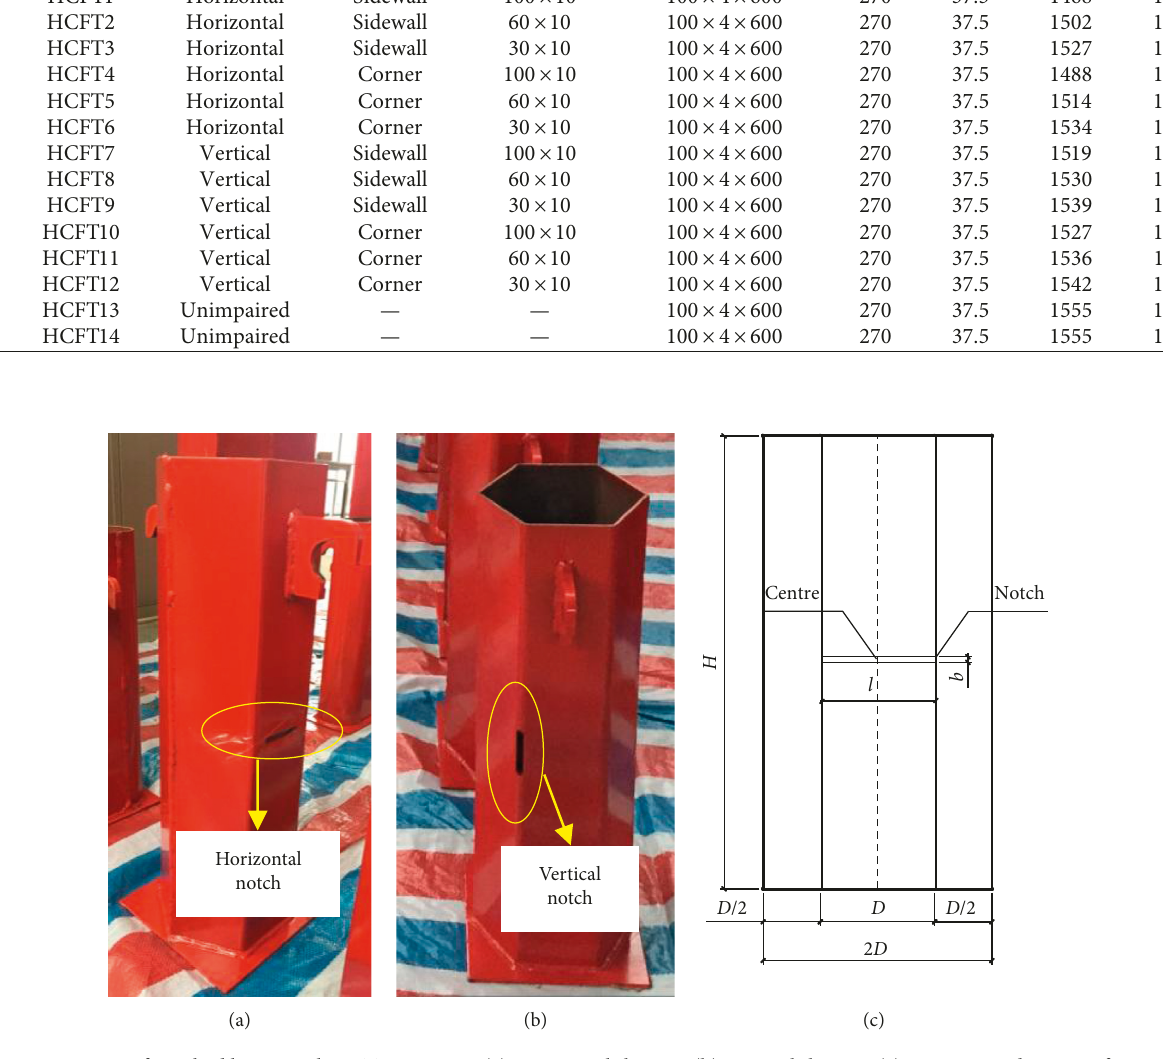
Figure 2: Diagram of notched hexagonal CFSTspecimens. (a) Horizontal slotting. (b) Vertical slotting. (c) Dimension diagram of a notched